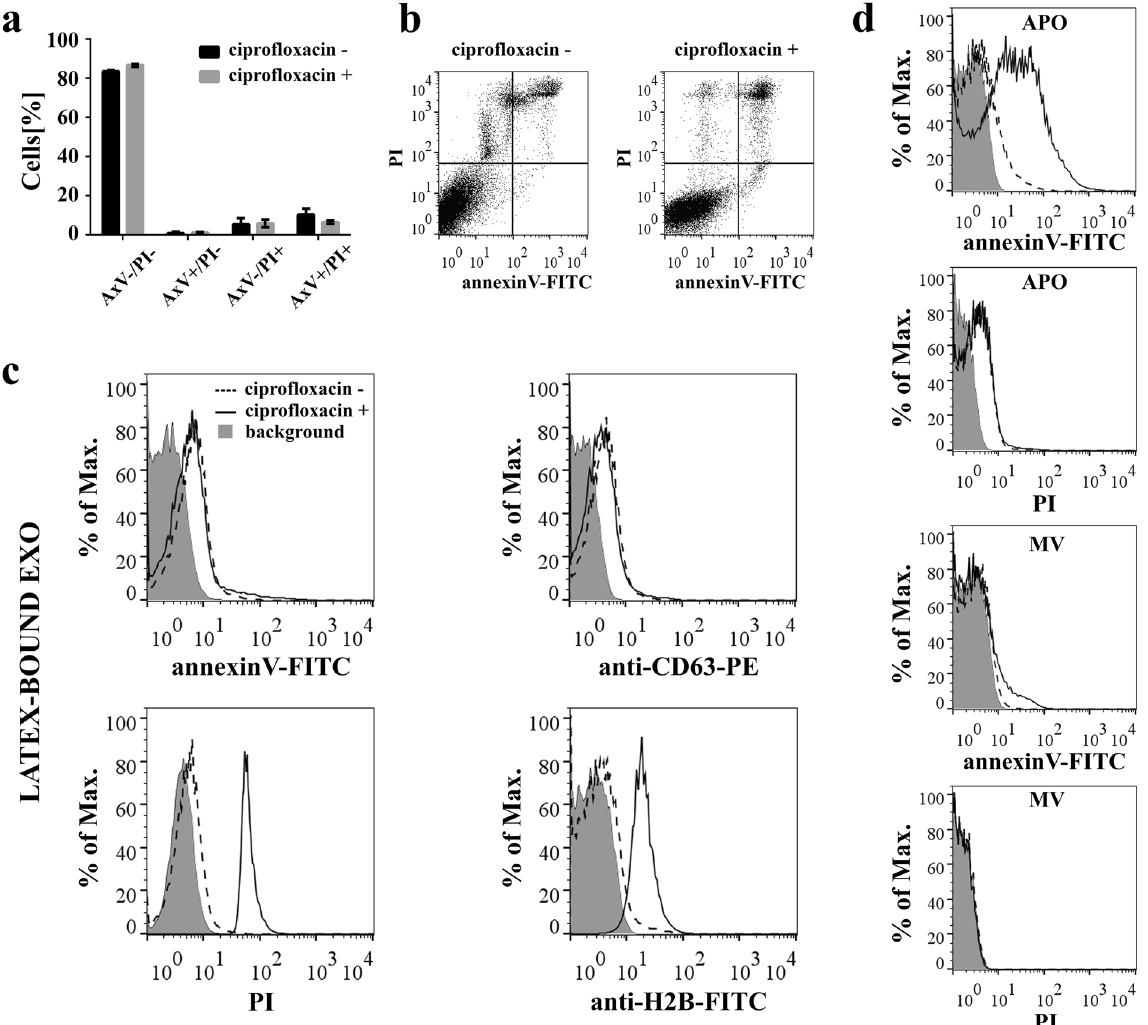
Figure 1. Effects of sustained ciprofloxacin exposure on Jurkat cells. (a,b) Viability of Jurkat cells with/ without exposure to ciprofloxacin (10 µ g/mL for > 14 days) was analyzed by flow cytometry after staining with annexinV-FITC and propidium iodide (PI). (a) Mean values + / − S.D. (error bars) of two independent experiments are shown in the histogram plot. AxV: annexinV. (b) Representative dot plots showing the four quadrants of annexinV-FITC and PI stained Jurkat cells. (c) Exosomes (EXOs) derived from ciprofloxacin- exposed/unexposed Jurkat cells were conjugated onto latex beads and characterized by flow cytometry after staining with annexinV-FITC, anti-CD63-PE, PI or anti-histone H2B-FITC. The background fluorescence of stained latex beads is indicated by grey histograms. (d) Microvesicles (MVs) and apoptotic bodies (APOs) were labeled directly with annexinV-FITC and PI. The background fluorescence of EVs is indicated by grey